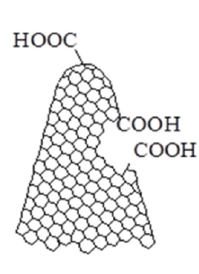
Figure 2. The structure of PVP.